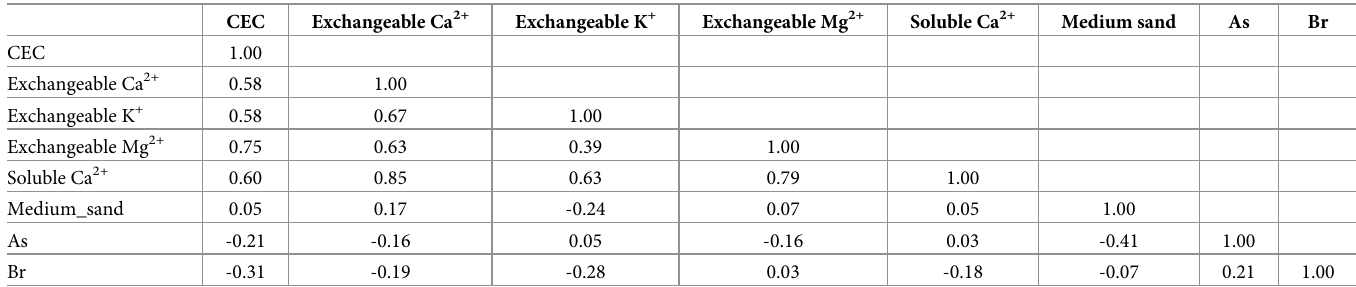
Table 4. Pearson correlation coefficients of the eight variables found to be potential indicators of a site with reported RVF